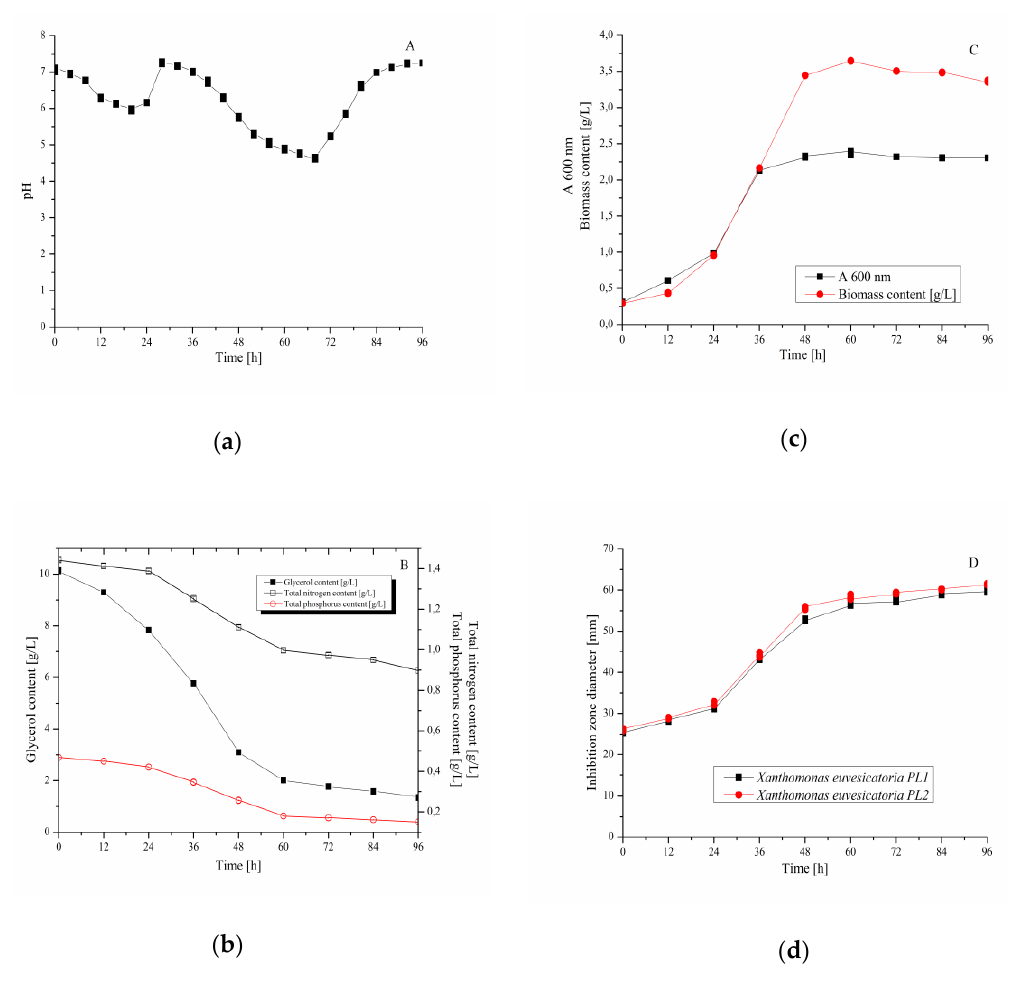
Figure 5. Course of B. velezensis IP22 cultivation in the laboratory-scale bioreactor in terms of: ( a ) pH value, ( b ) residual nutrients’ content, ( c ) biomass content, ( d ) antimicrobial activity against X. euvesicatoria isolates.